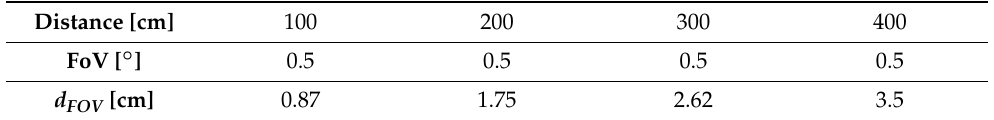
Table 2. Field of view for the TF03 LiDAR for different distances to target. Distance